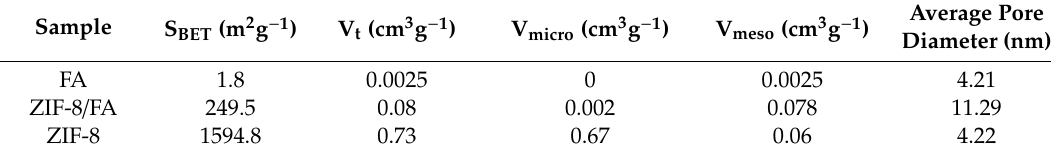
Figure 6. Pore size distribution of ( a ) FA, ( b ) ZIF-8 / FA, and ( c ) ZIF-8. Table 1. Specific surface area and porosity of FA, ZIF-8 and ZIF-8/FA composites.